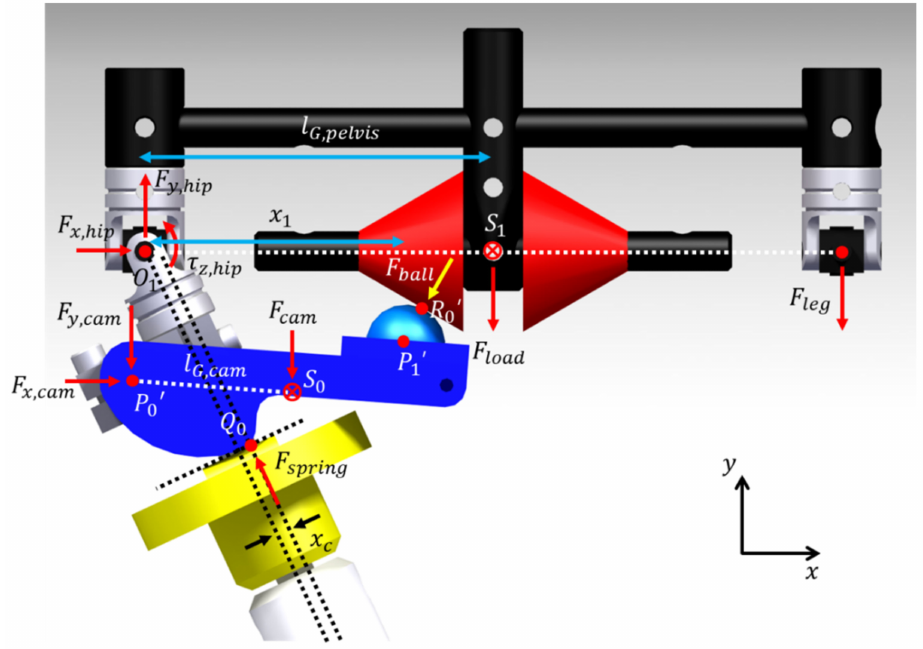
Figure 3. Dynamic system in the proposed